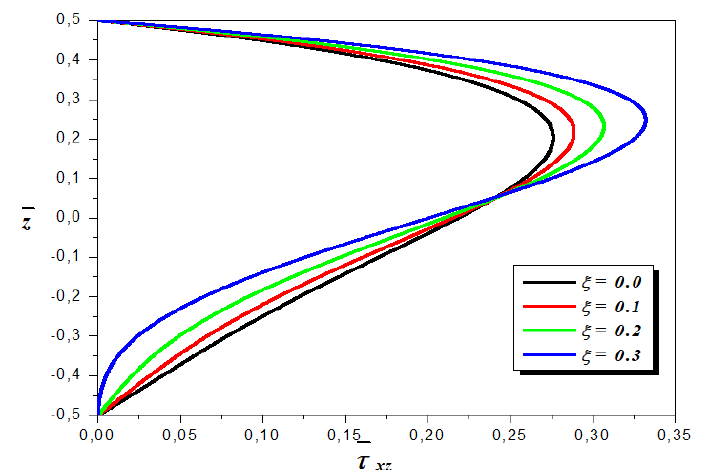
Figure 6: Via the thickness distributions of the FG shear stress (a/h=10 and p=2